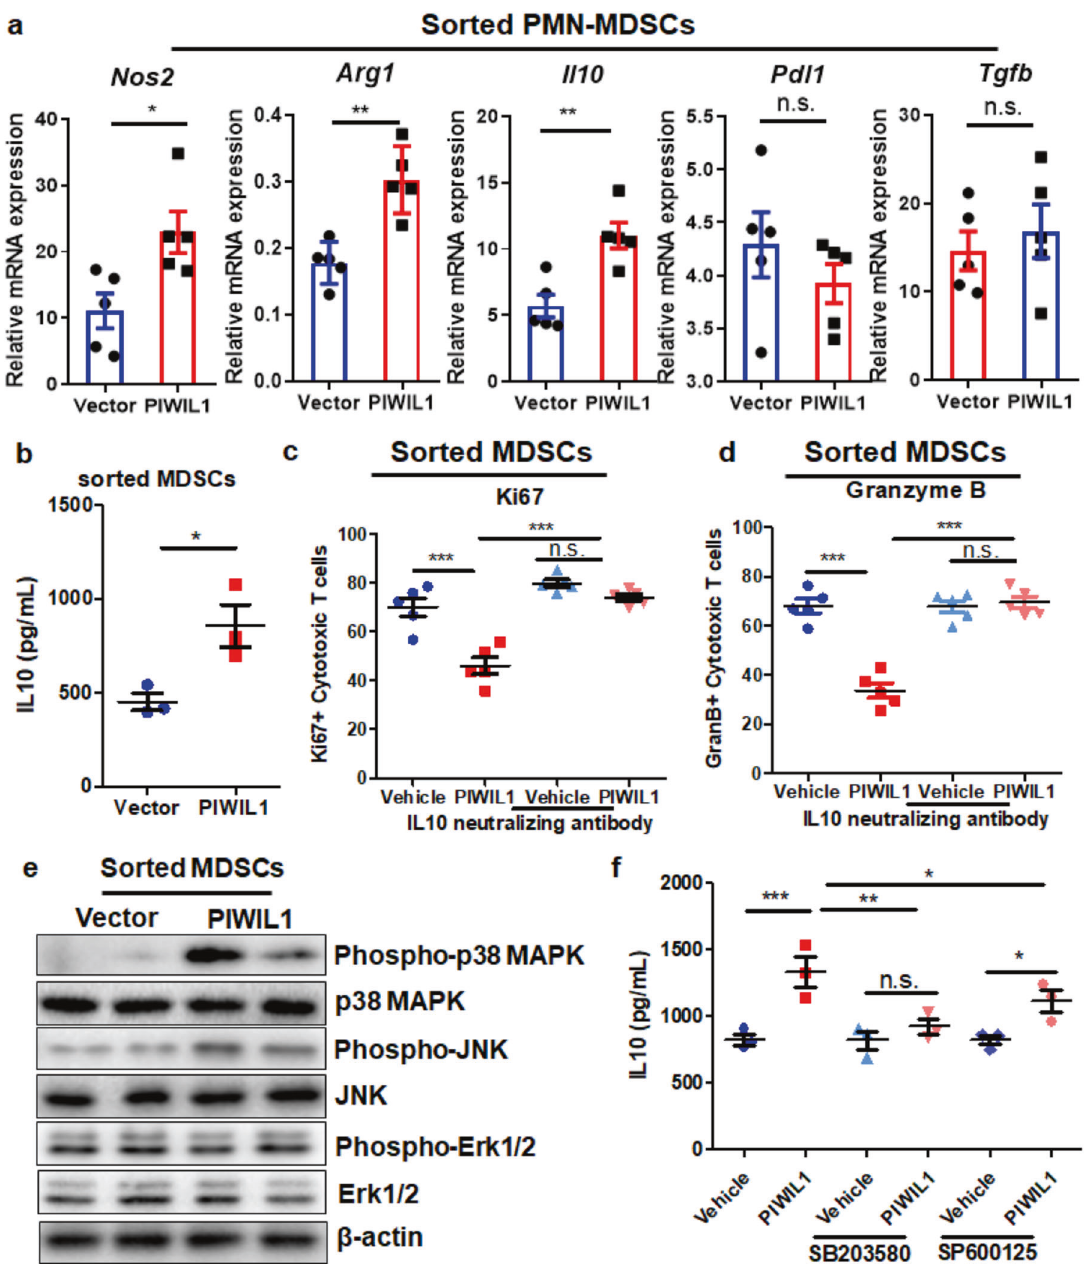
Fig. 5 MDSCs of PIWIL-overexpressing HCC suppresses T-cell proliferation and activation through IL10-dependent manner. The PMN-MDSCs in the hepatic tissues surrounding wild type or PIWIL1-overexpressing HCC were sorted and cultured. Signi fi cantly higher expression of PMN- MDSCs genes ( a ) and IL10 production ( b ) were observed in PMN-MDSCs from PIWIL1-overexpressing HCC; The PMN-MDSCs in the hepatic tissues surrounding wild type or PIWIL1-overexpressing HCC were sorted and co-cultured with simulated CD8 + cytotoxic T cells in the presence of IL10 neutralizing antibody. IL10 neutralizing antibody could potentially recover the c Ki67 and d Granzyme B expression in these T cells; e Protein was extracted from sorted PMN-MDSCs, and the phosphorylation of p38 MAPK and JNK were found induced in sorted PMN- MDSCs from MDSCs induced by conditioned medium from PIWIL1-overexpressing HCC cells; BMDMs was incubated with conditioned medium from PIWIL1-overexpressing HCC cells following pre-incubation of p38 MAPK inhibitor SB203580 (10 μ M) or JNK inhibitor SP600125 (10 μ M) for 60 min. The protein secretion of IL10 was signi fi cantly suppressed by SB203580 or SP600125 ( f ). All experiments were performed in triplicate. * p < 0.05; ** p < 0.01; *** p <